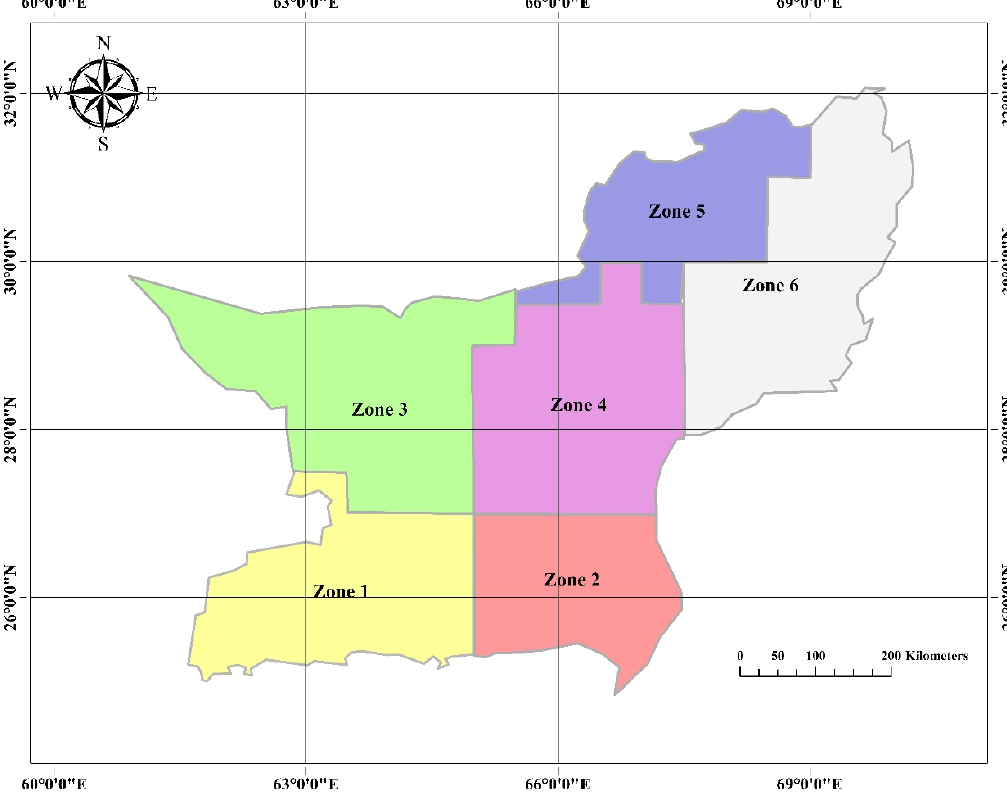
Figure 4. Homogeneous zones produced after running Spatial “K”luster Analysis using Tree Edge Removal